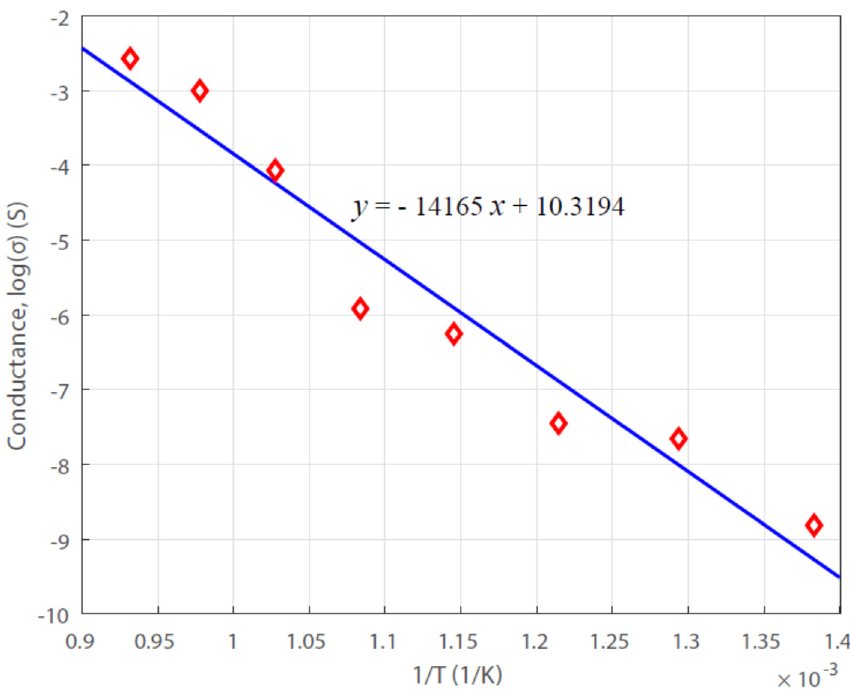
ff erent stages of pyrolysis